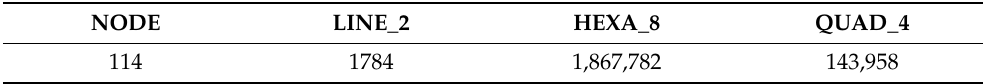
Table 3. Different element types.